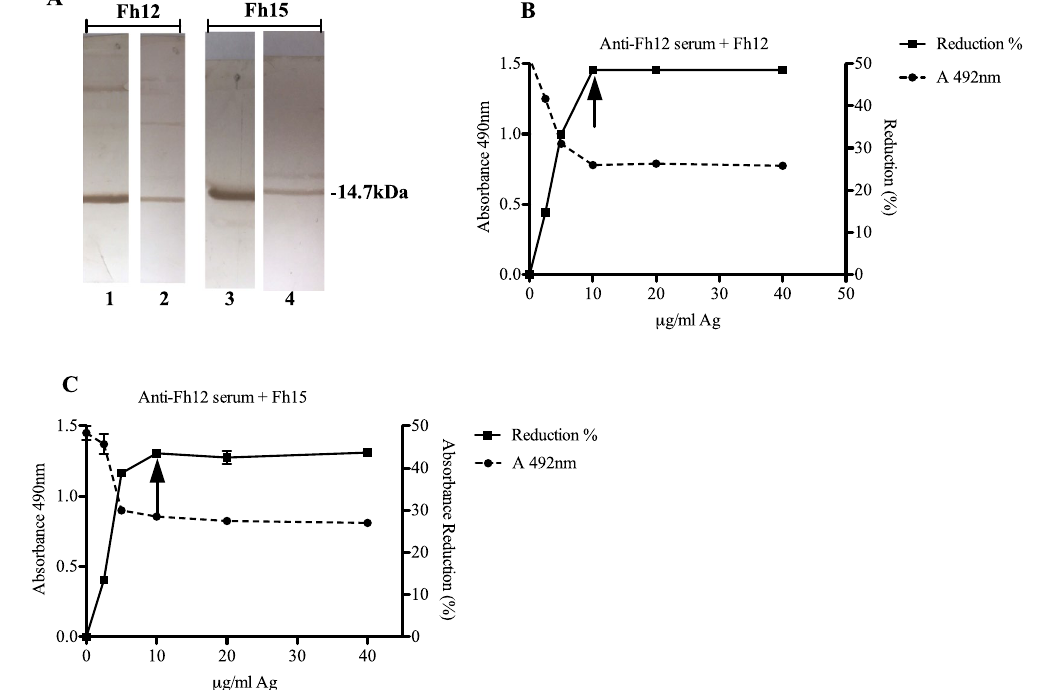
Figure 2. Western blot and Inhibition ELISA analysis of purified Fh15 with anti-Fh12 or anti-ESP serum. Immunological identity between Fh15 and Fh12 was investigated. ( A ) Fh15 and Fh12 were analyzed by 15% SDS-PAGE, electrotransferred to nitrocellulose membranes and incubated with anti-Fh12 antibody (lanes 1 & 3) revealing a strong immunoreactive band of ~14.7 kDa, or incubated with anti-ESP antibody (lanes 2 & 4), respectively, revealing the band of ~14.7 kDa at weaker intensity. Figure 2A represents cropped images from the original. Original full-length gels and blots are shown in Supplementary Figure 1. In the Inhibition ELISA, the plate was coated with 15 μ g/ml Fh12. Anti-Fh12 antibody (diluted 1:200) was mixed with increased amounts of Fh12 ( B ) or Fh15 ( C ) ranging from 2.5 to 40 μ g/ml and after 1 h incubation at 37 °C was added to the plate. The secondary antibody was further added diluted 1:5000 followed by the substrate solution. Maximal inhibition values of ~43.5–48.5% were obtained at concentrations starting at 10 μ g/ml protein, which is indicated on the figure with an